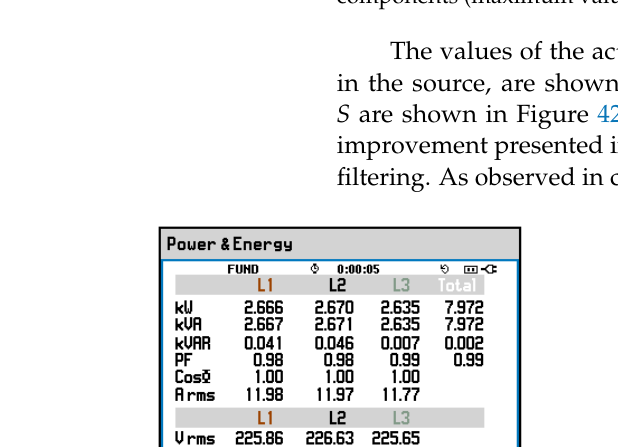
Figure 41. Case 5 - ZSS and three-wire ShAPF operating with unbalanced loads: ( a ) three-phase currents; ( b ) harmonic spectrum of the currents; ( c ) harmonic spectrum of the current sequence components (maximum values).